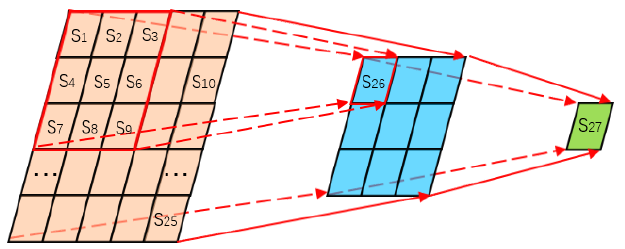
Figure 7. Convolution operation principle.